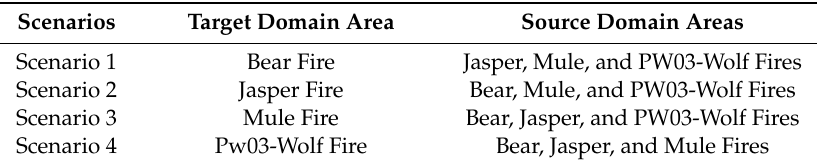
Table 2. Evaluation scenarios of